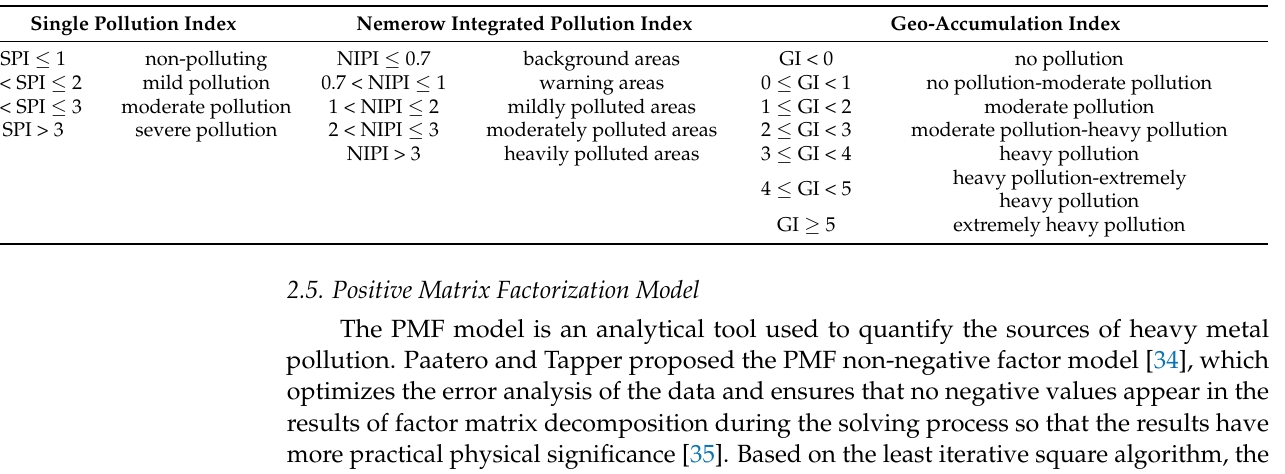
Table 1. Classification standard for soil heavy metal pollution using three methods